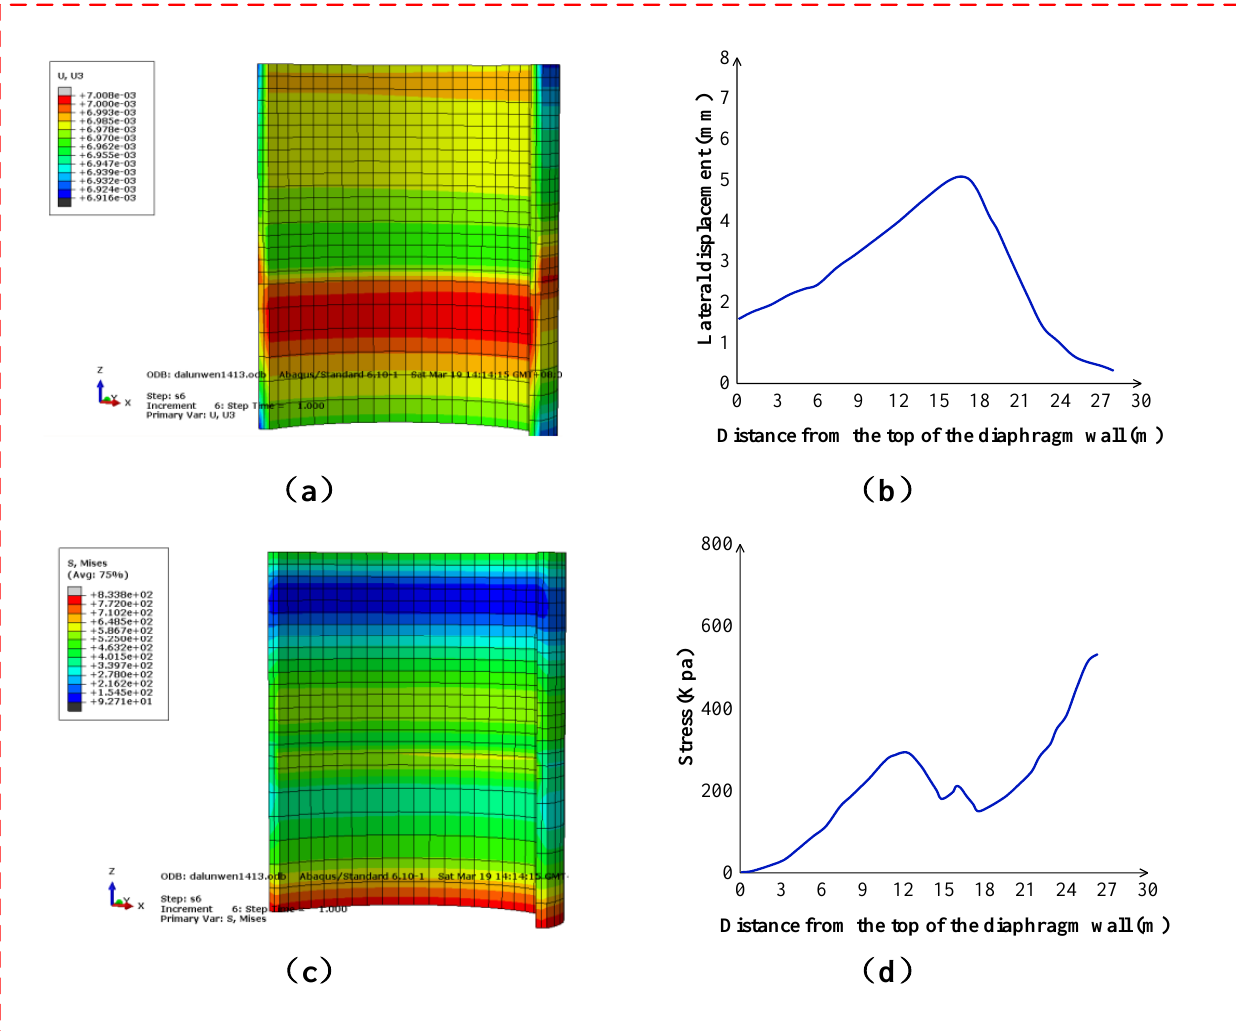
Figure 15. Lateral displacement diagram and stress map after excavation of a continuous underground wall: (a) lateral displacement cloud map of underground diaphragm wall; (b) lateral displacement coordinate map of underground diaphragm wall; (c) stress cloud map of underground diaphragm wall after excavation; (d) stress coordinate map of underground diaphragm wall after excavation.